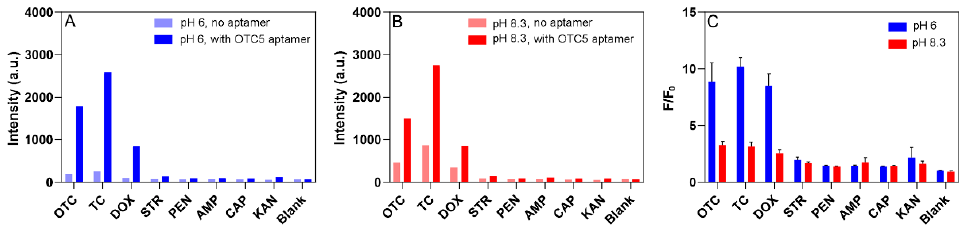
Figure 8. Selectivity of the OTC5 aptamer in ( A ) pH 6.0 MES buffer and ( B ) pH 8.3 Tris buffer, each with 2 mM Mg 2+ . An amount of 2 μ M of OTC5 was added to 100 nM of antibiotic. Samples were scanned at an excitation wavelength of 370 nm and emission of 530 nm. ( C ) The fluorescence difference at pH 6.0 and 8.3 with and without OTC5. STR: streptomycin; PEN: penicillin; AMP: ampicillin; KAN: kanamycin.